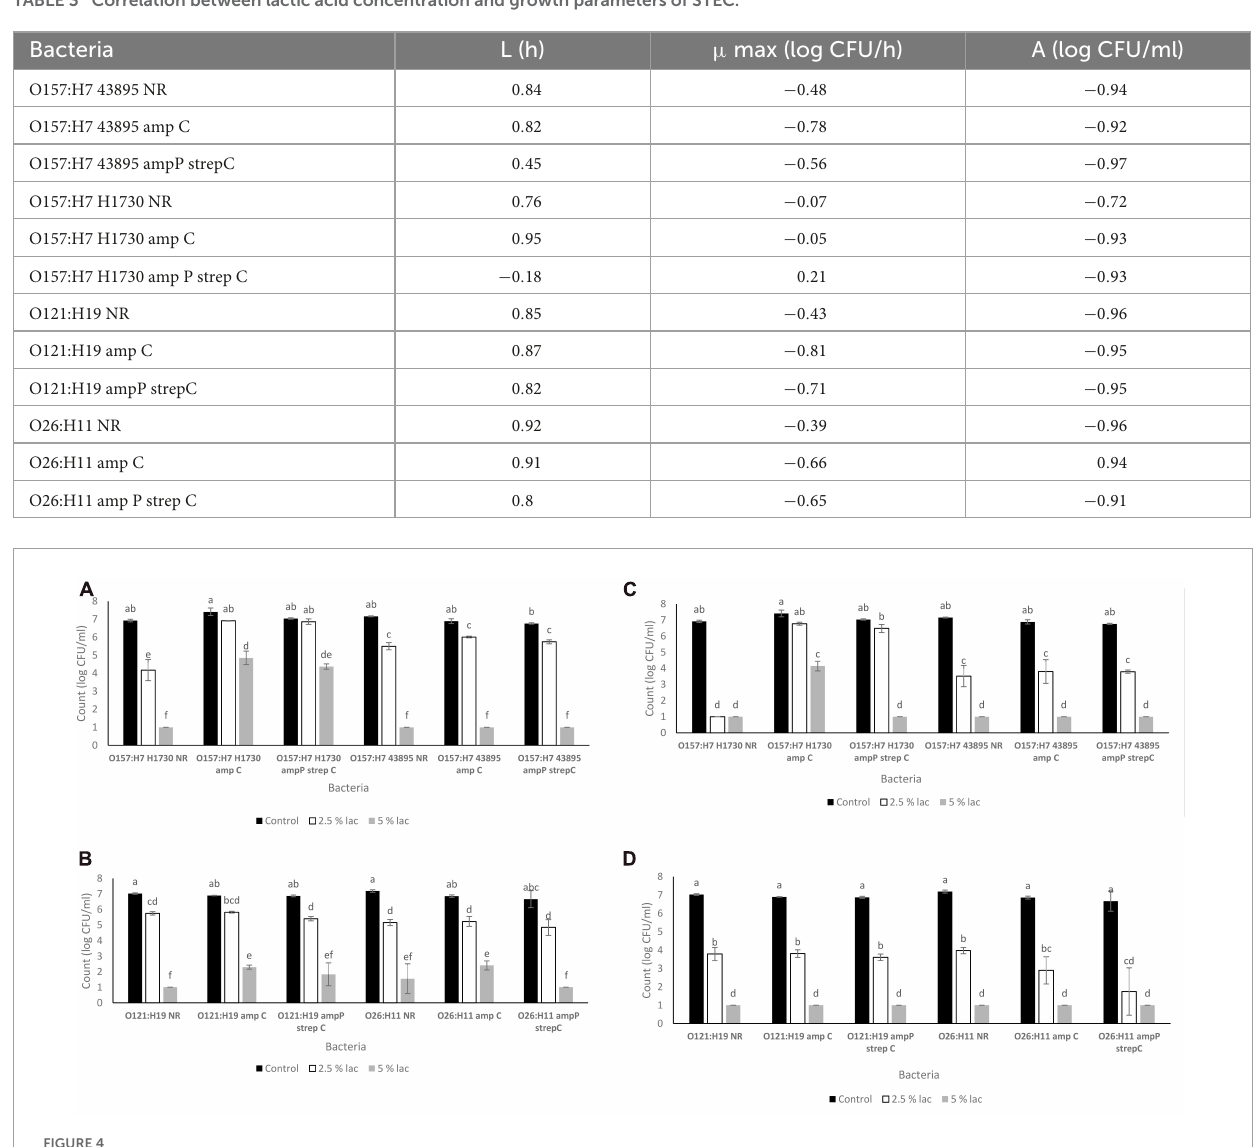
FIGURE4 Survival of STEC exposed to lactic acid (A) . O157 STEC exposed to lactic acid for 30 s (B) O121 and O26 STEC exposed to lactic acid for 30 s (C) . O157 STEC exposed to lactic acid for 300 s (D) . O121 and O26 STEC exposed to lactic acid for 300 s. Significant differences among strains have been denoted by different